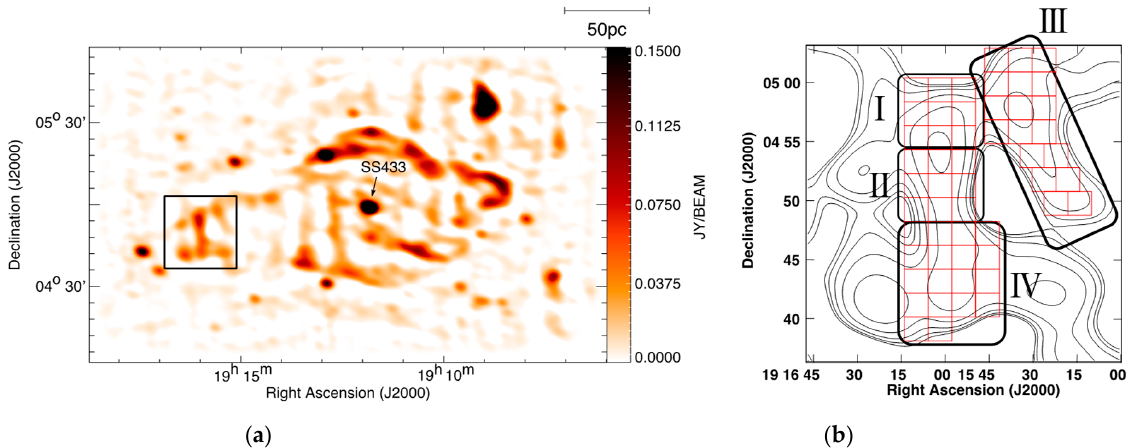
Figure 1. ( a ) An image of W50 observed with the ATCA at 3.0 GHz. The black box is the region shown in the right panel. ( b ) The eastern edge region of W50. Contours show the total intensity at 3.0 GHz. The filament consists of regions I, II, and IV. Regions I and II correspond to the northern and southern terminal shock, respectively. Region III is part of the helical structure. Region IV corresponds to the southern part of the filament. Red pixels show regions analyzed in this paper.